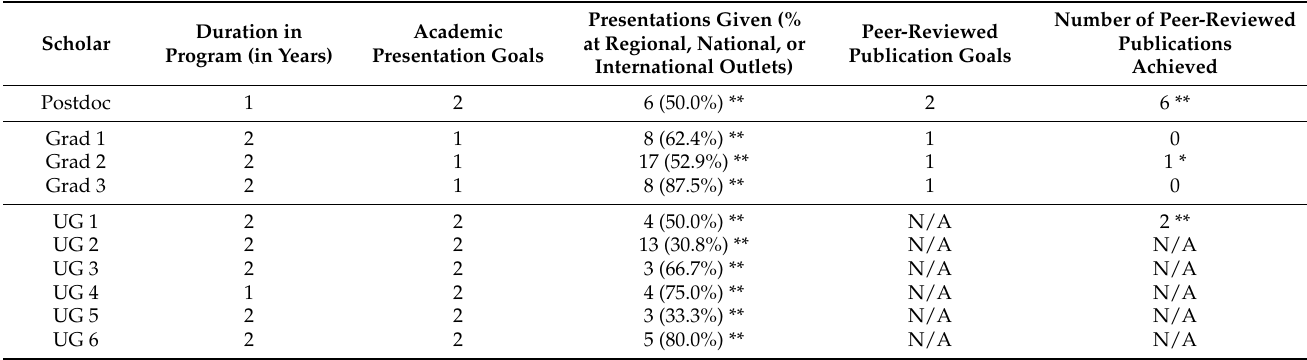
Table 3. UHAND Scholars’ Academic Products † and Program Retention, Cohort 1 (N = 10).